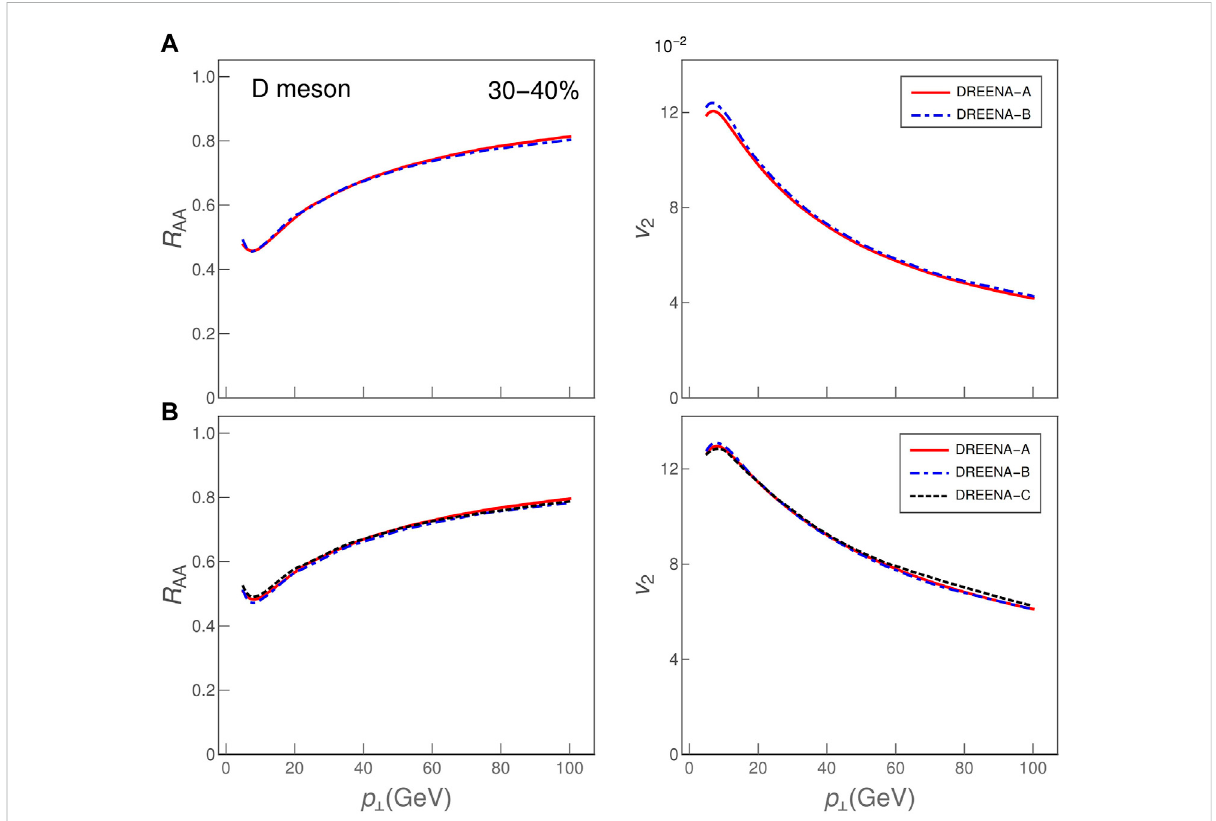
FIGURE 4 Comparison of different DREENA frameworks, for Bjorken medium evolution (A) and for constant medium temperature approximation (B) , demonstrating inter-framework consistency. (A) show D meson R AA (left) and v 2 (right) at 30 – 40% centrality computed using DREENA-A (supplied with temperature pro fi les representing Bjorken evolution) and DREENA-B. (B) show the same observables, computed using all three DREENA frameworks, when applied to the same constant temperature medium. M = 1.2 GeV, μ M / μ E =